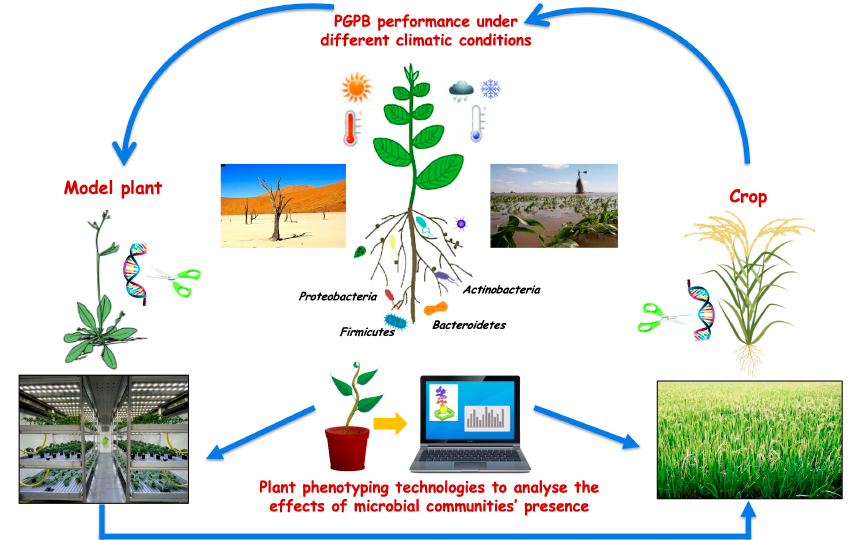
Figure 1. Plant Growth Promoting Bacteria (PGPB) for sustainable agriculture: link between laboratory and field experiments.